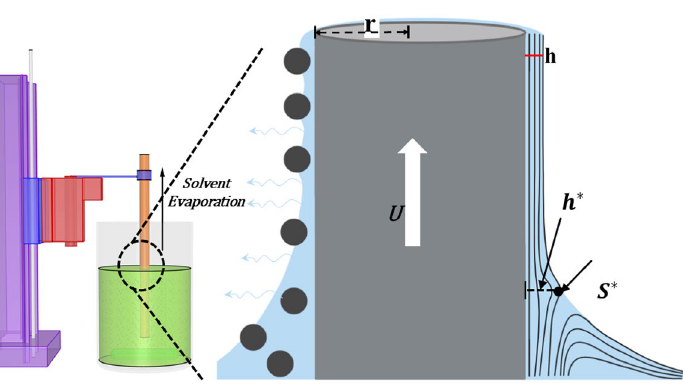
Figure 6. Schematic of fluid streamlines and dip coating mechanism. S ∗ denotes for the stagnation point, h for expected liquid thickness, h ∗ for the critical film thickness, r for fiber radius, and U for withdrawal